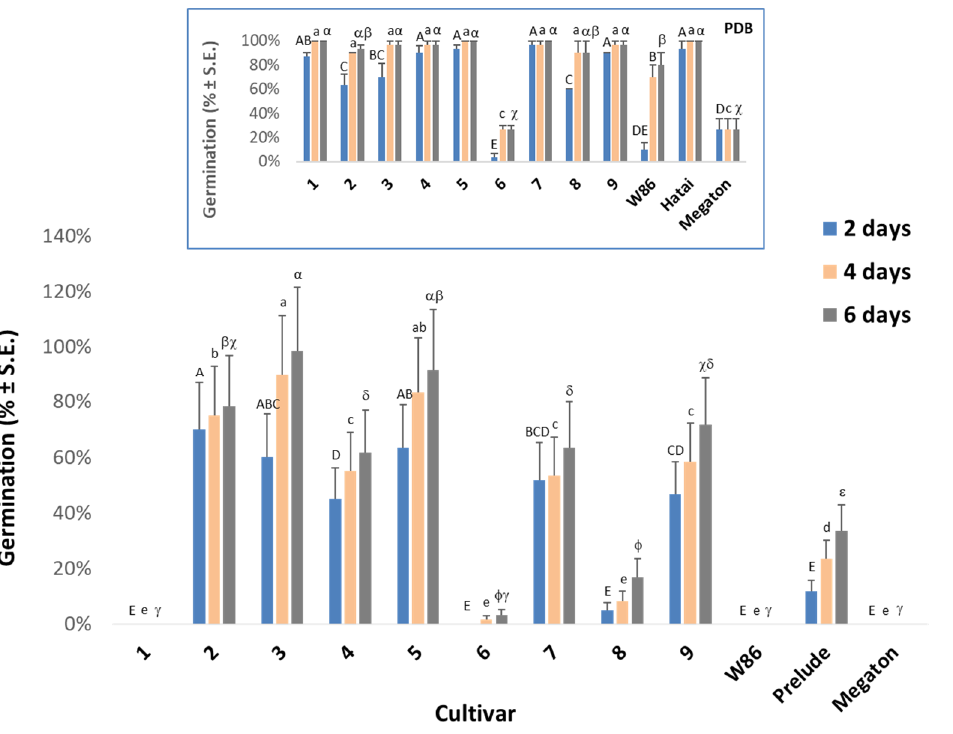
Figure 1. Seed pathogenicity assay to evaluate the maize cultivars’ resistance to late wilt disease. The seeds of the maize cultivars tested (Table 1) were kept for 6 h in an M. maydis growth medium filtrate (obtained from 7-day-old fungus colonies grown in a potato dextrose broth (PDB) rich medium). The treated seeds were incubated in Petri dishes in humid conditions, at 28 ± 1 °C in the dark. Germination percentages were tested every two days for up to six days. Insert—the cultivars’ seed germination in PDB without the fungus. Vertical upper bars represent the standard error of the mean of 10 repeats (Petri dishes containing 10 seeds). Different letters above the bars represent a significant difference ( p < 0.05) in an analysis of variance (ANOVA) assay.